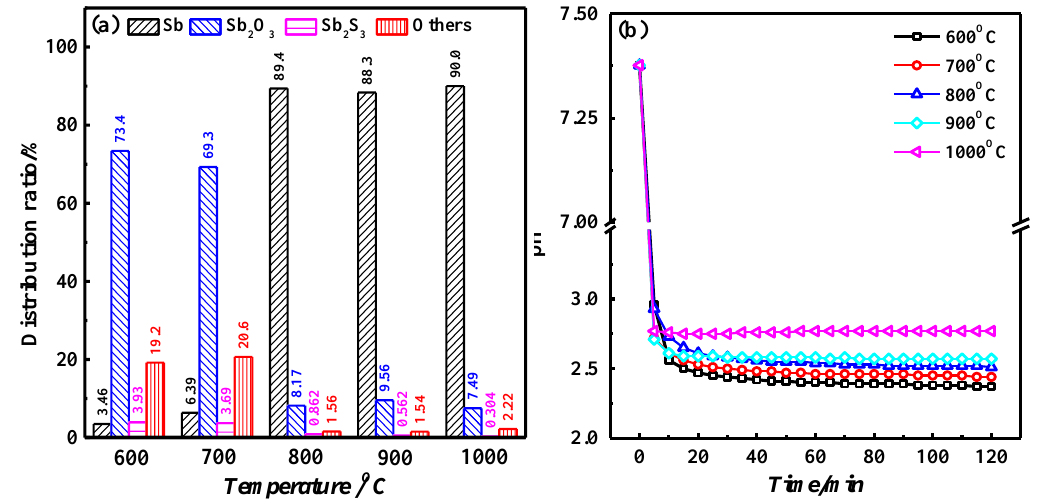
Figure 4. ( a ) Phase distribution ratios of the roasted products at different temperatures; and ( b ) pH values of the KMnO 4 solution.